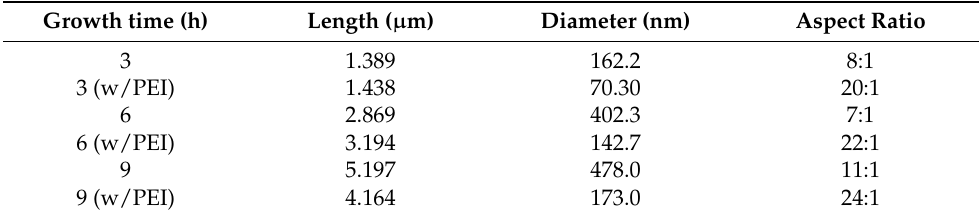
Table 1. Summarized diameter, length, and aspect ratios of ZNRs prepared with various growth times at 90 °C without and with PEI in precursor solutions.